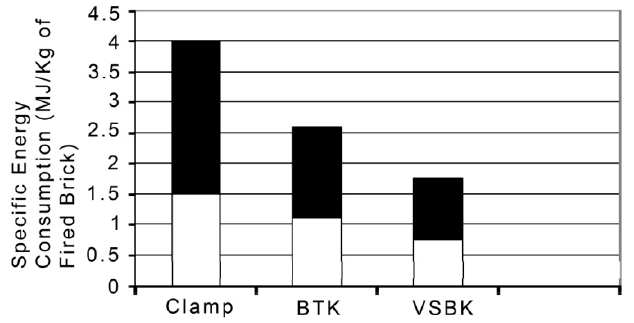
Figure 2. Energy consumption of VSBK, bull’s trench kiln (BTK) and clamp kilns [26].